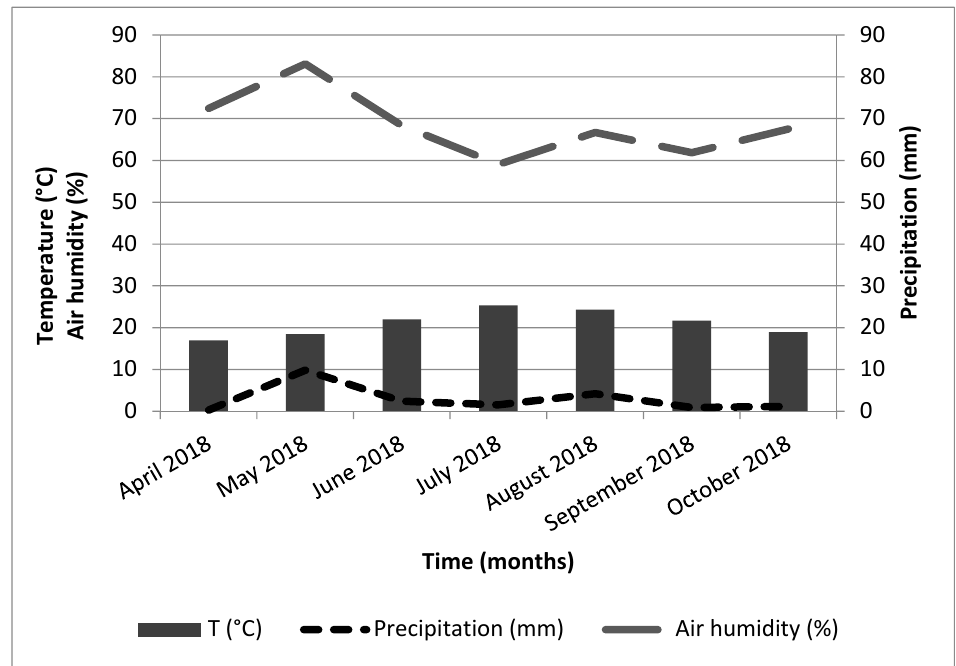
Figure 3. Trend of main climatic parameters: temperature (°C), precipitation (mm) and air humidity (%) recorded during the storage of Eucalyptus from April to October 2018.